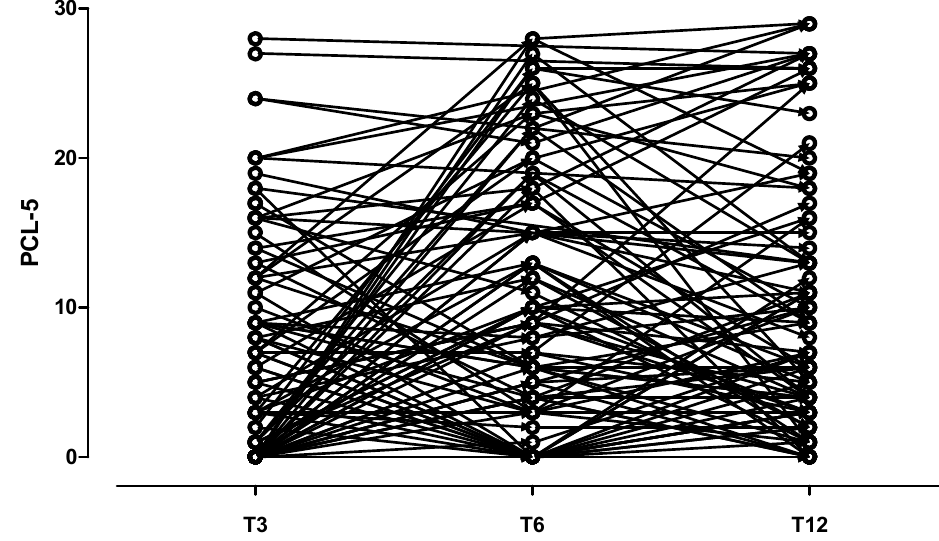
Figure 1. PCL-5 total score trajectories in patients without PTSD.